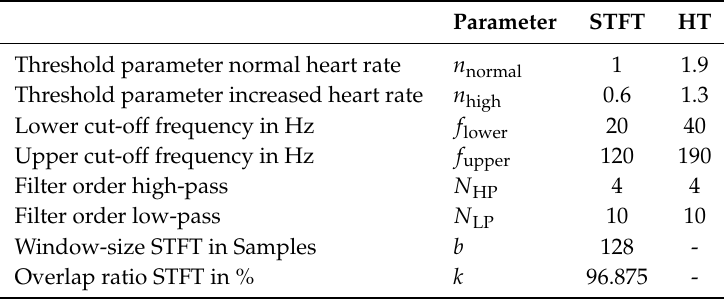
Table 3. Optimization results for of the heart sound classification.